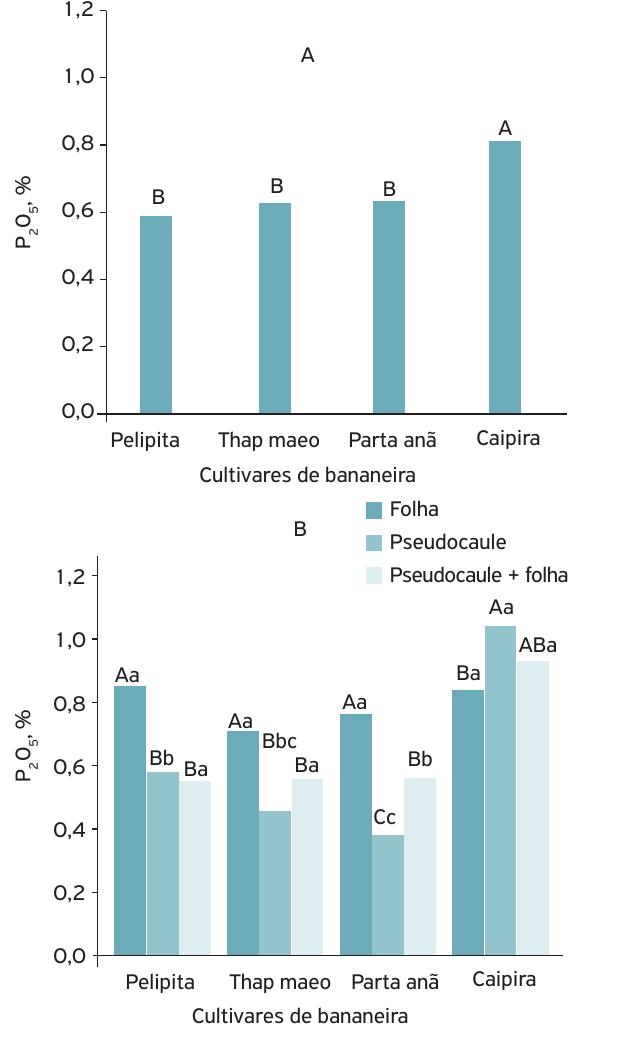
O , %, presente no substrato à O, %, presente no substrato à base de Figura 7. (A) Teores de P Figura 8. (A) Teores de K 2 5 2 base de quatro cultivares de bananeira (Thap maeo, Prata resíduos de bananeira (pseudocaule, folha e pseudocaule + folha) anã, Pelipita e Caipira) antes da colonização pela linhagem antes de sua colonização pela linhagem 09/100 de Pleurotus 09/100 de Pleurotus ostreatus . (B) Teores de P O (%) O(%) presente no substrato à base de ostreatus. (B) Teores de K 2 5 2 presente no substrato formulado à base de quatro cultivartes resíduos (pseudocaule, folha e pseudocaule + folha) de quatro cultivares de bananeira (Thap maeo, Prata anã, Pelipita e Caipira) e após 49 dias de colonização pela linhagem 09/100 de Pleurotus ostreatus. Letras maiúsculas comparam médias dentro de um mesmo cultivar de bananeira; letras minúsculas comparam médias dentro de cada tipo de resíduo. Médias seguidas de letras iguais não diferem entre si (Tukey, 5%) (Média de duas